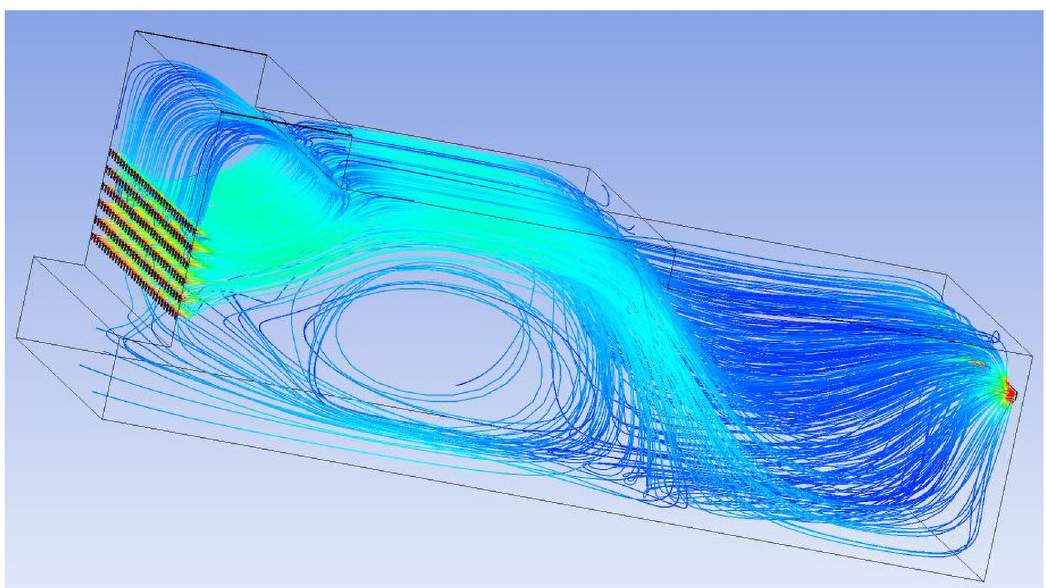
Fig 7. Three-dimensional airflow field streamline diagram.